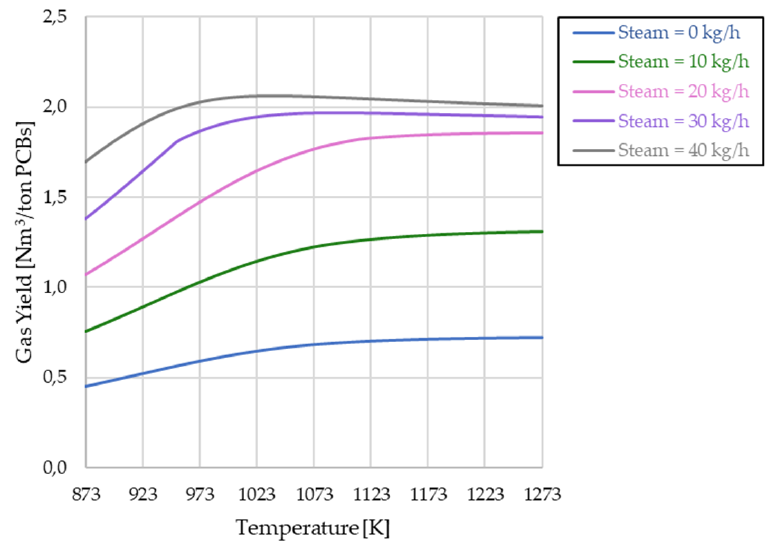
Figure 8. The effect of high temperatures on syngas yield for different steam Figure 8 . The effect of high temperatures on syngas yield for different steam streams.